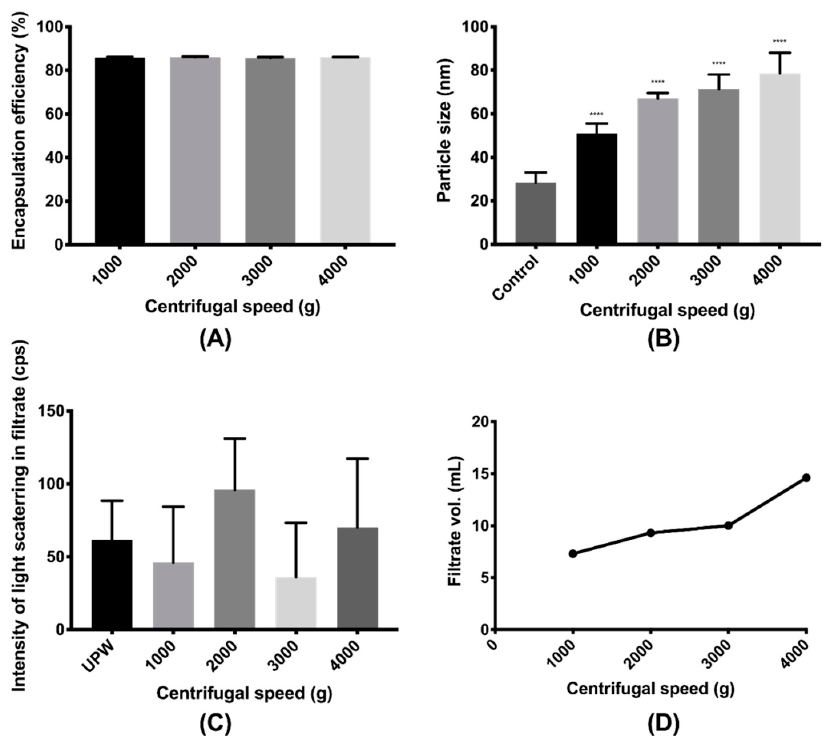
Figure 5. Effects of centrifugal speed on the ( A ) encapsulation efficiency and ( B ) particle size of the FLU nanoparticle as well as ( C ) intensity of light scattering in filtrate and ( D ) volume of the filtrate for duration of 20 min (**** denotes 0.0001 ≥ p comparing with control).